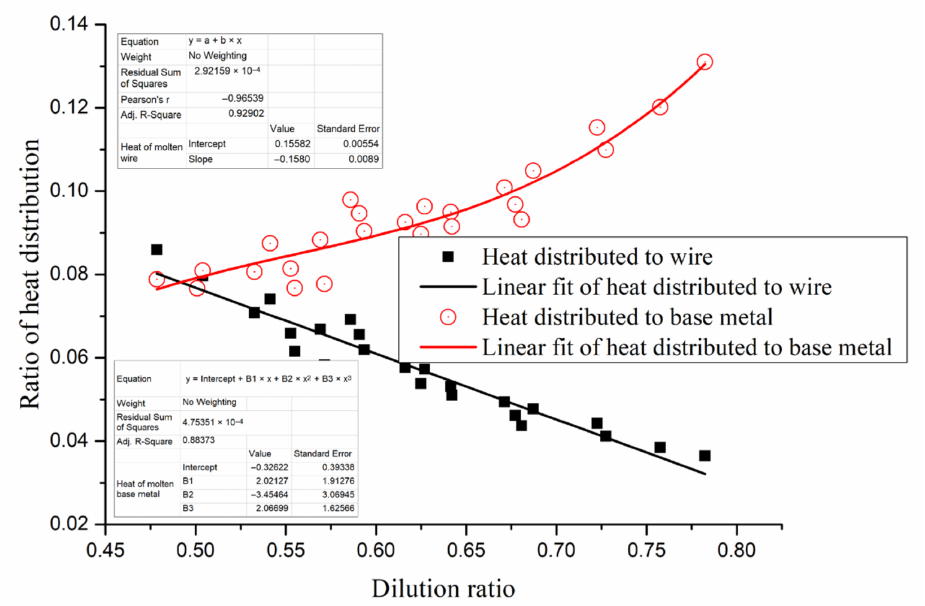
Figure 9. The corresponding relationship between the ratio of the heat of molten base metal and welding wire to the effective heat input of the whole welding and dilution